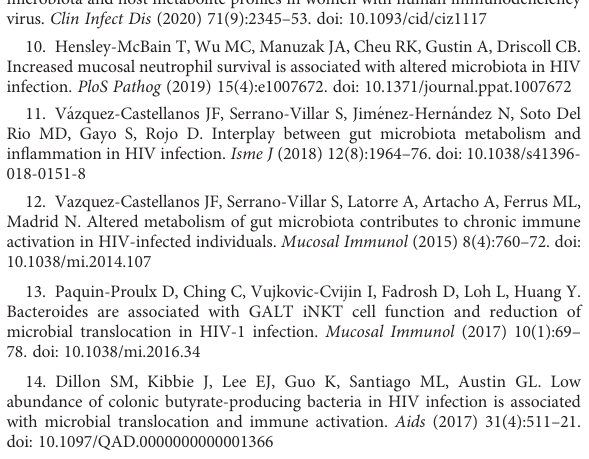
SUPPLEMENTARY FIGURE 1 The activated CD4+ and CD8+ T cells at the different stages of HIV infection. Example of intracellular activated CD4+ and CD8+ T cells from PBMCs of AIDS patients (A-D) , pre-AIDS patients (E-H) and healthy controls (I-L) . SUPPLEMENTARY FIGURE 2 Butyric acid at different stages of HIV infection. SUPPLEMENTARY FIGURE 3 The association between bacterial genera and metabolites positively correlated with immune activation and microbial translocation. SUPPLEMENTARY FIGURE 4 The association between bacterial species and metabolites positively correlated with immune activation and microbial translocation. SUPPLEMENTARY FIGURE 5 The association between bacterial genera and metabolites negatively correlated with immune activation and microbial translocation. SUPPLEMENTARY FIGURE 6 The association between bacterial species and metabolites negatively correlated with immune activation and microbial